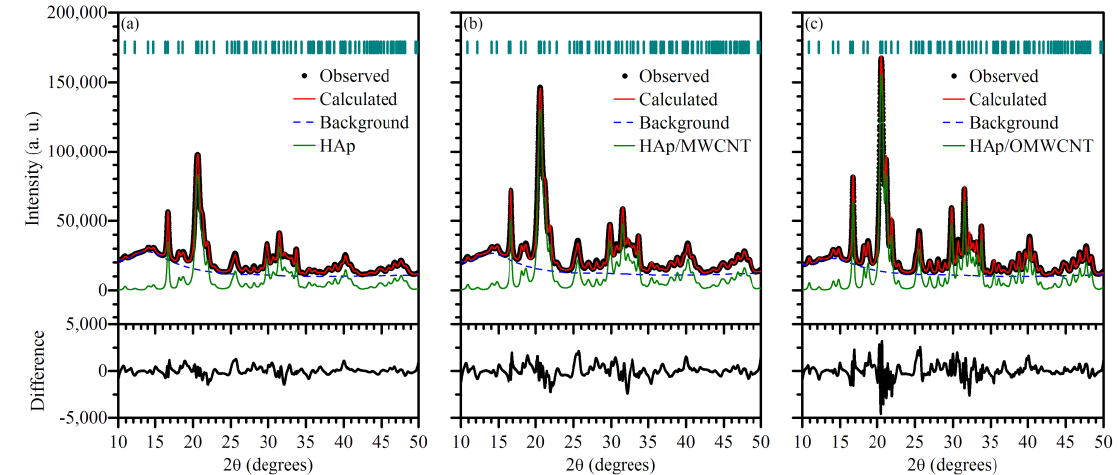
Figure 3. Rietveld refinement plot of HAp ( a ), HAp/MWCNT ( b ), HAp/OMWCNT ( c ).